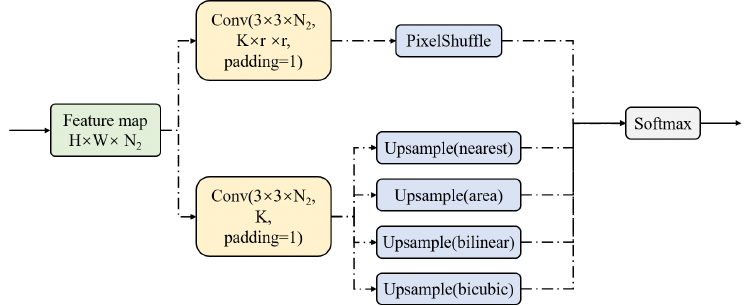
Figure 5. The optional upsampling architectures at the end of the network.